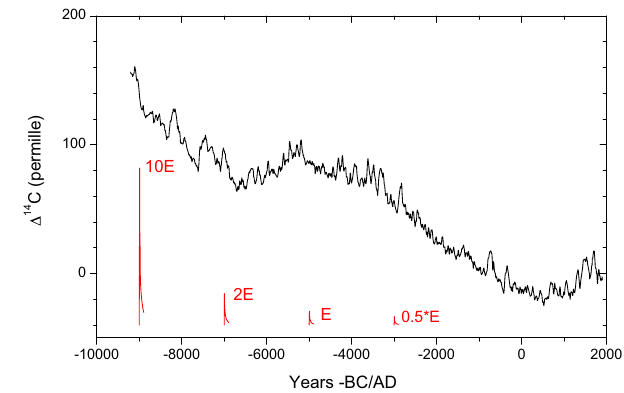
1001E-61E-51E-41E-30.010.11 1 ] r - [ y 30 ) > F P ( / Space era / Terr. data Lunar data 0.1 1 10 Annual fluence F [10 9 protons cm -2 yr -1 30